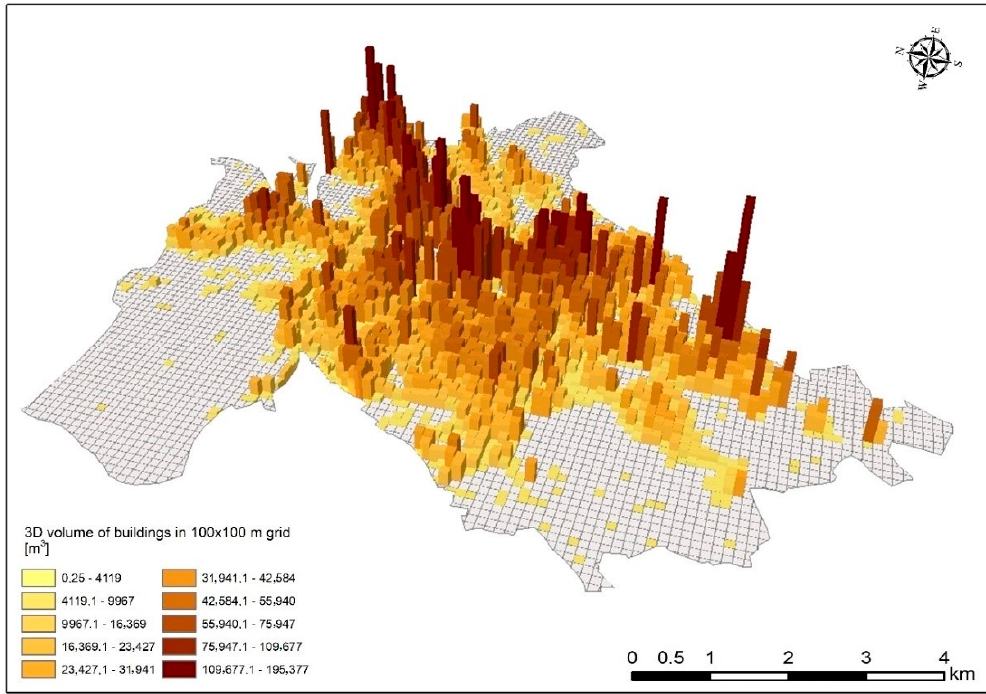
Figure 12. Volume of buildings in a grid (100 × 100 m) in 3D view (Luxembourg City, 2019). The Building 3D Density Index (B3DI) calculated for the City in 2019 is 1.09 m 3 /m 2 . The city